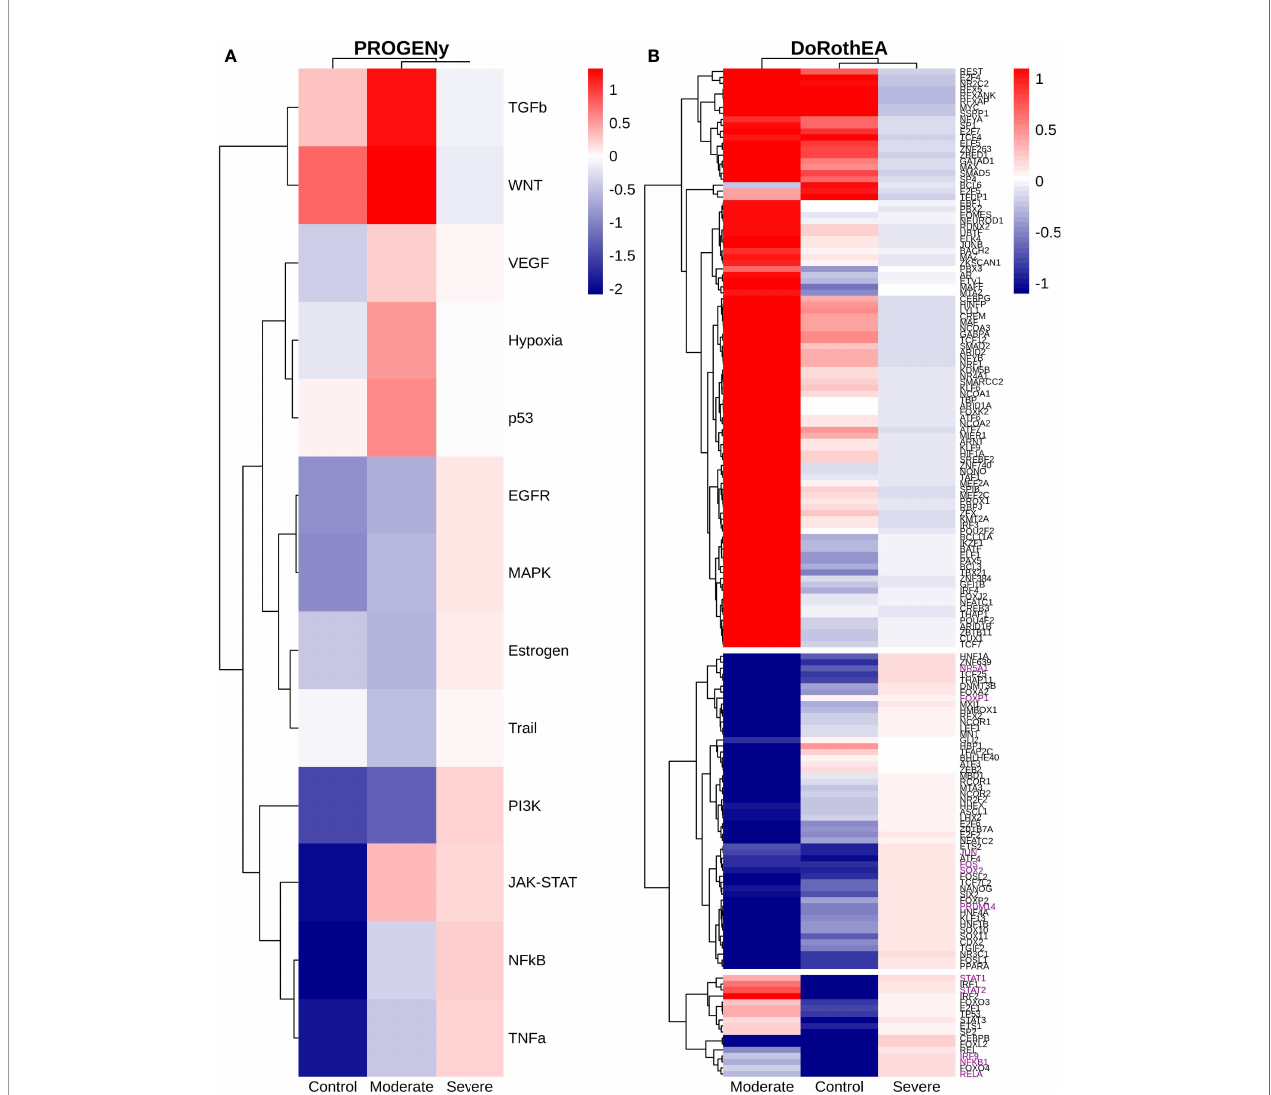
FIGURE 8 | TFs associated with the disease severity in Dendritic cells. (A) Resulting Heatmap from DoROthEA analysis. (B) Resulting Heatmap from PROGENy analysis. Colorbar sets the activation (red) and inactivation (blue)